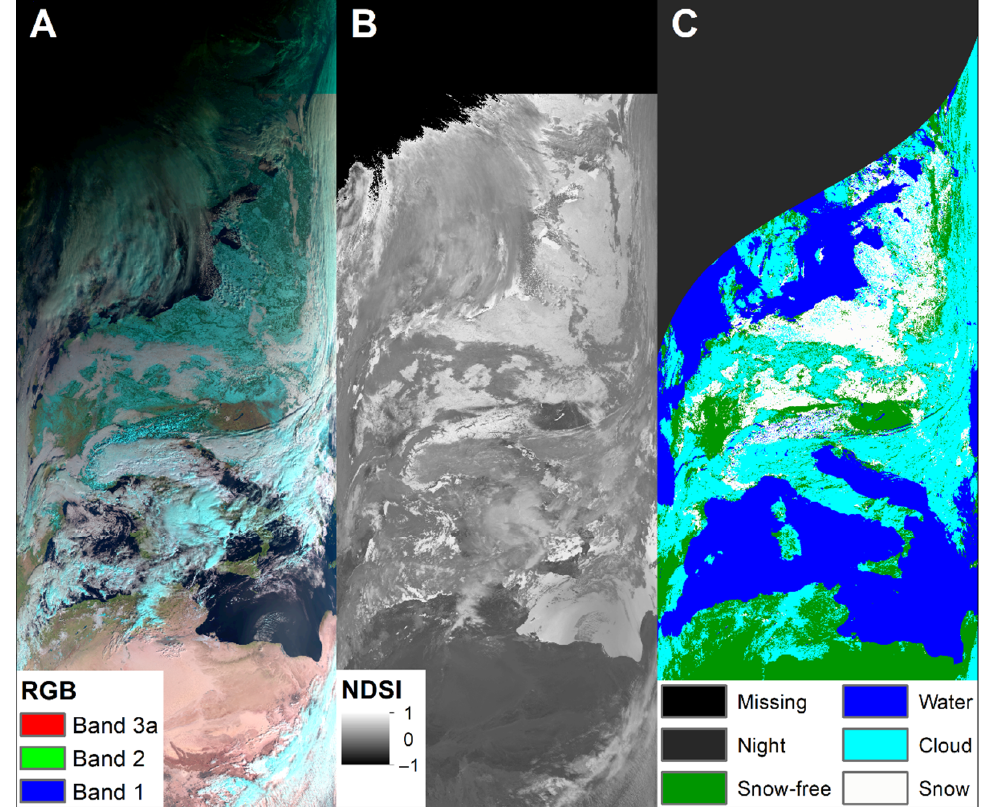
Figure 5. Example of a Level 2 snow cover product in satellite swath projection from 08.01.2009 (recording time 09:15:00–09:26:26 UTC); Platform NOAA-17; Sensor AVHRR/3. ( A ) RGB composite from the Level 1b bands 3a, 2, 1; ( B ) from band 1 and band 3a calculated NDSI (gradient of